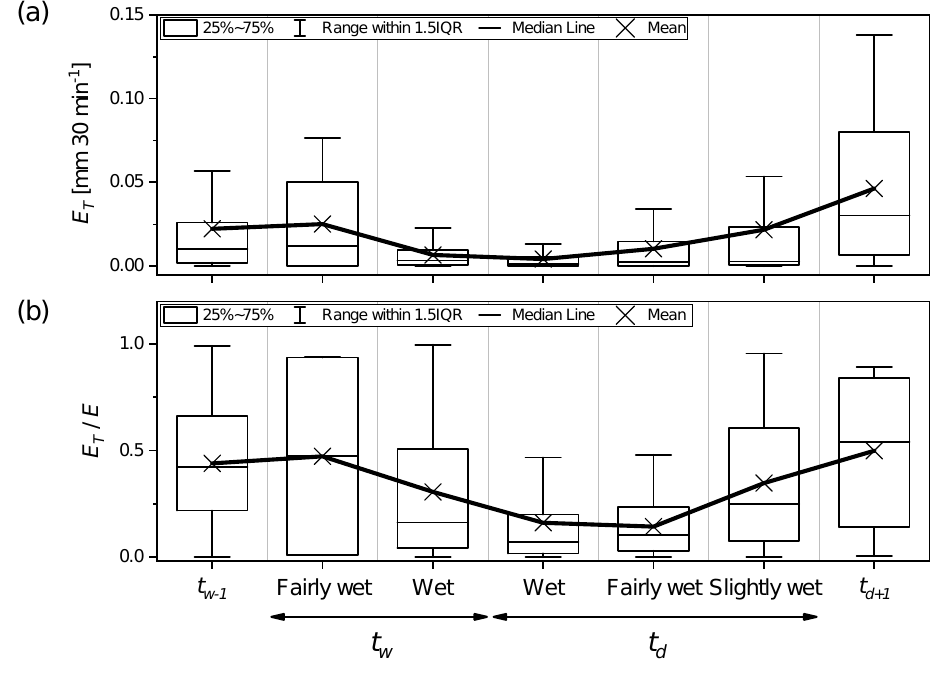
Figure 8. Variations of ( a ) E T and ( b ) E T / E before wetting phase ( t w − 1 ), during wetting ( t w ) and drying ( t d ) phases as well as after the canopy became completely dry ( t d + 1 ). E T and E T / E variability is described by the interquartile range (IQR). The solid bold lines are connecting the means of each